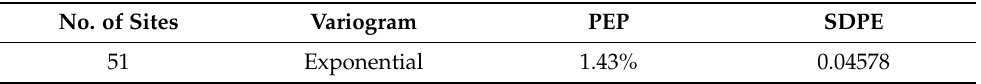
Table 6. Quantitative analysis results of exponential variogram of WEEE return for J company.